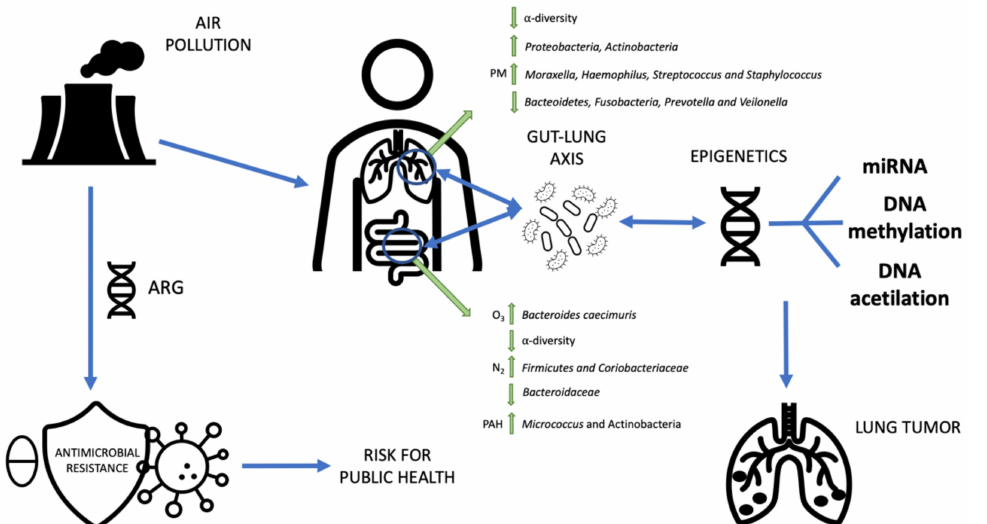
Figure 2. Bidirectional communication between the lung and gut microbiota. The impact of envi- ronmental pollution, including the airborne resistome, on human lung health is influenced by the lung–gut axis microbiome and epigenetic regulation. The green arrows represent the microorganisms that change after exposure to air pollution